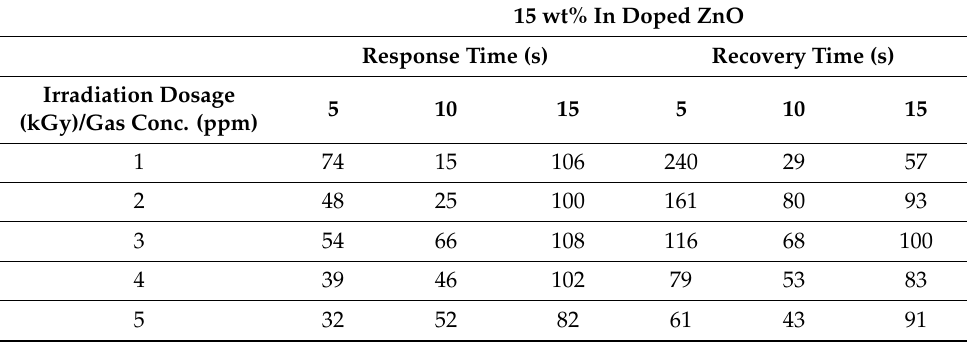
Figure 6. Band diagram of the proposed sensing mechanism ( a ) Sensor in dry air ( b ) Sensor in CO gas. The sensing response curves of e-beam treated IZO thin films are shown in Figure 7. The 5 and 10 kGy irradiated films were able to detect the CO concentration lower to 1 ppm whereas 15 kGy irradiated film could not detect 1 ppm. The response time and recovery time are calculated and given in Table 2. Table 2. Response time and recovery time of irradiated IZO sensors.